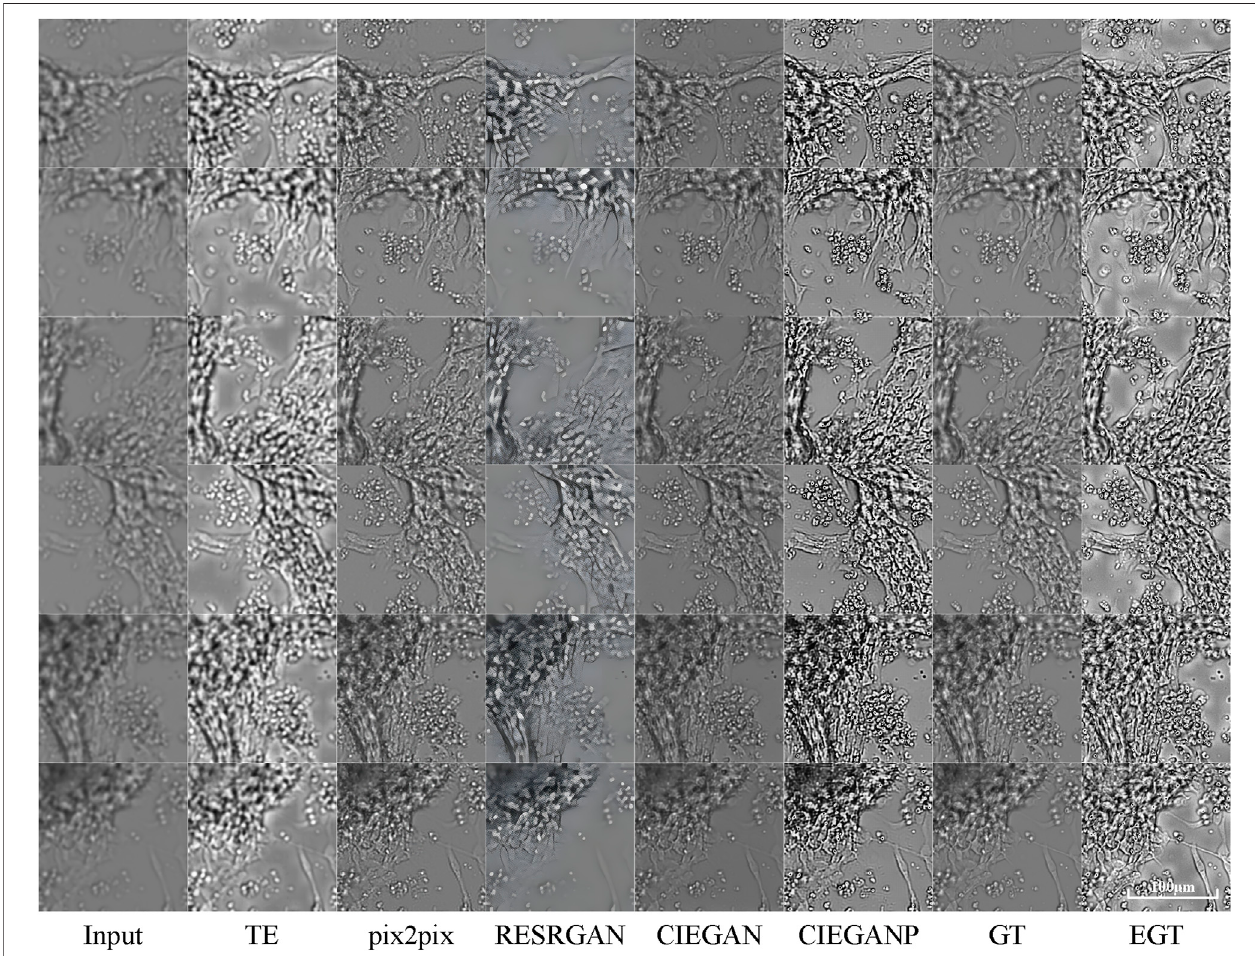
FIGURE 8 | Comparison results of bright fi eld image enhancement of the iPSC-CM differentiation experiment. TE stands for the traditional enhancement method, CIEGAN, CIEGAN plus (CIEGANP) is our method, GT is the ground truth, and EGT is the enhanced ground truth. “ pix2pix ” is the method proposed by Isola et al. (2017) and RESRGAN is the real-ESRGAN method proposed by Wang et al.